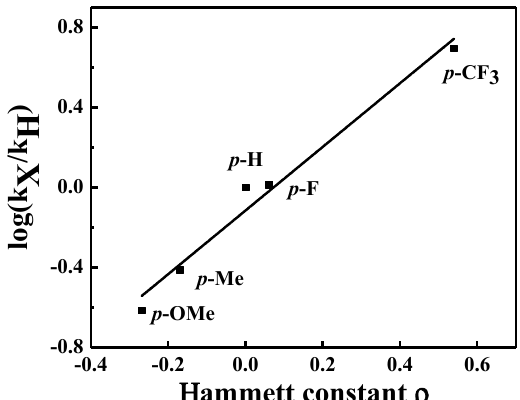
Figure 2. Correlation study for catalytic reduction of various aromatic aldehydes to the corresponding aromatic alcohols. Reaction conditions: substrate (1 mmol), γ -Fe 2 O 3 @HAP-Pd (10 mg)catalyst, 25 °C, H 2 (10 bar), H 2 O (10 mL).